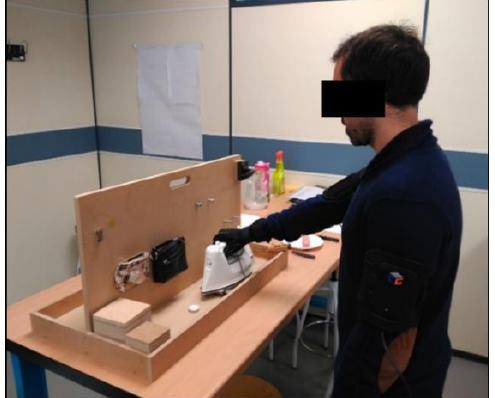
Figure 4. A participant performing the Sollerman Hand Function Test while wearing the 22 DoF